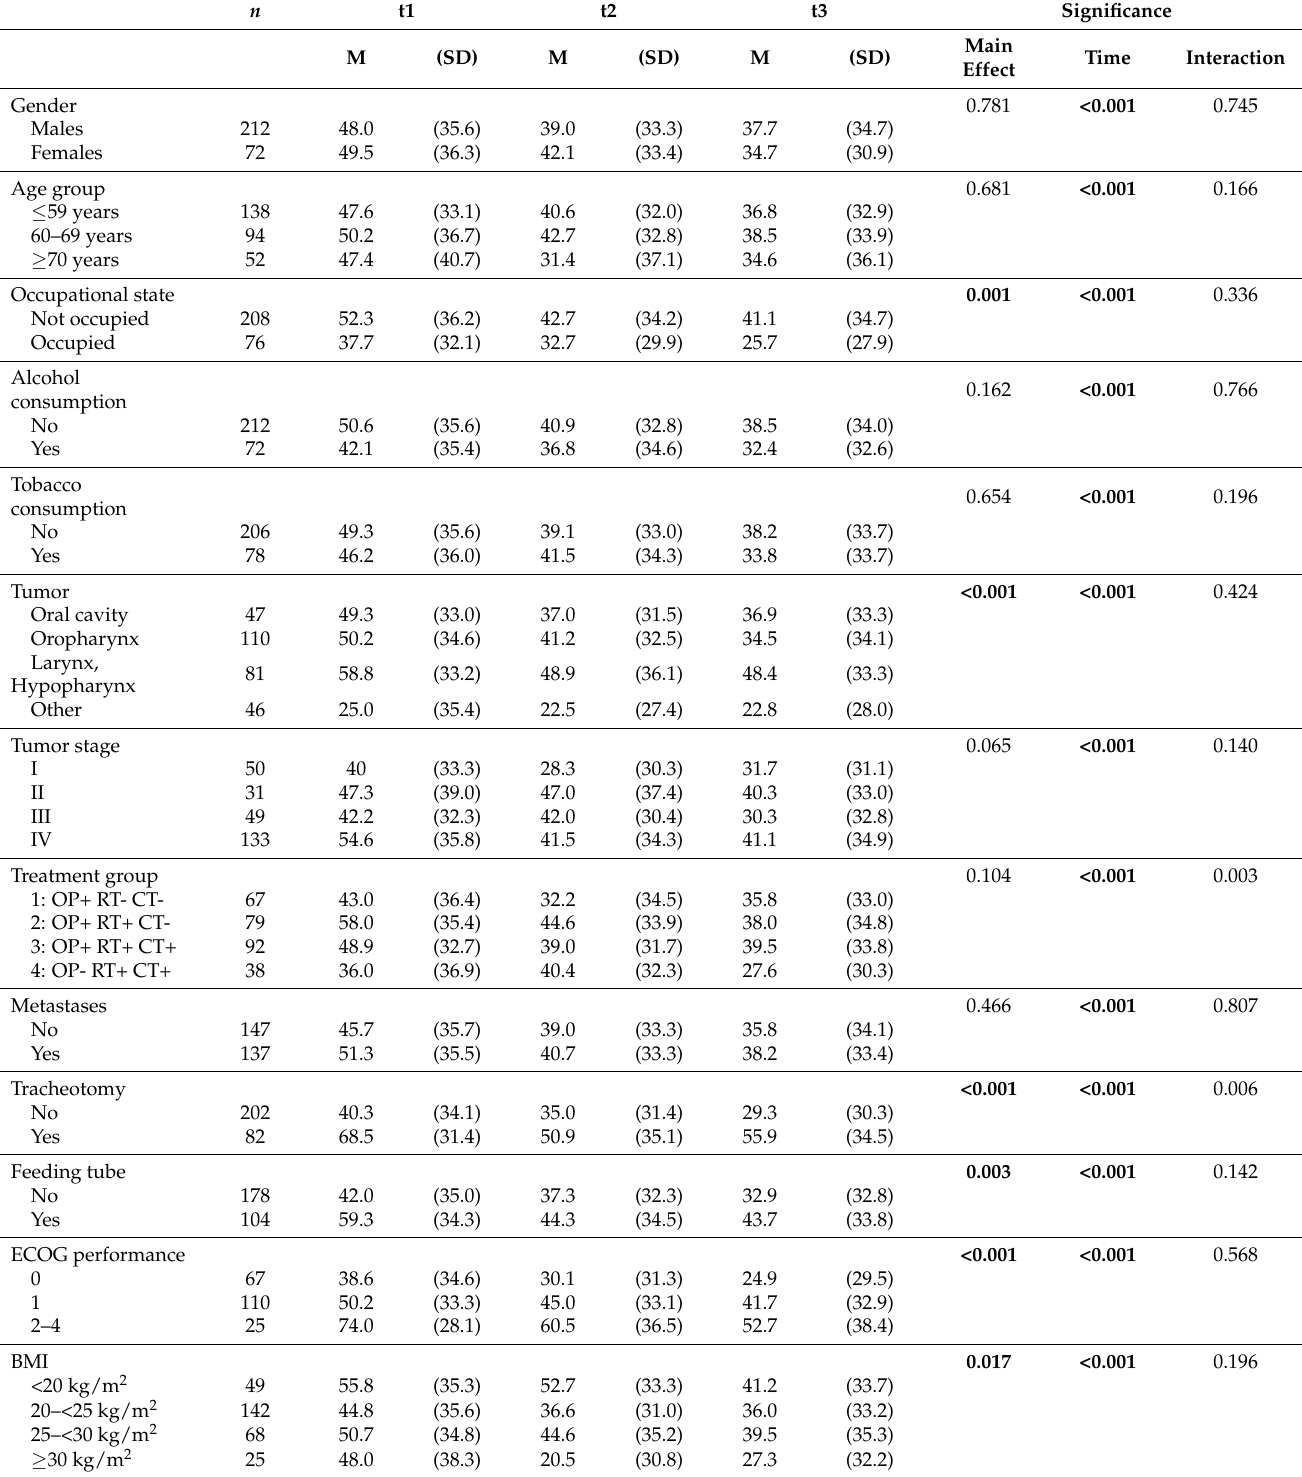
Table 4. Voice problems: Mean scores depending on sociodemographic and clinical